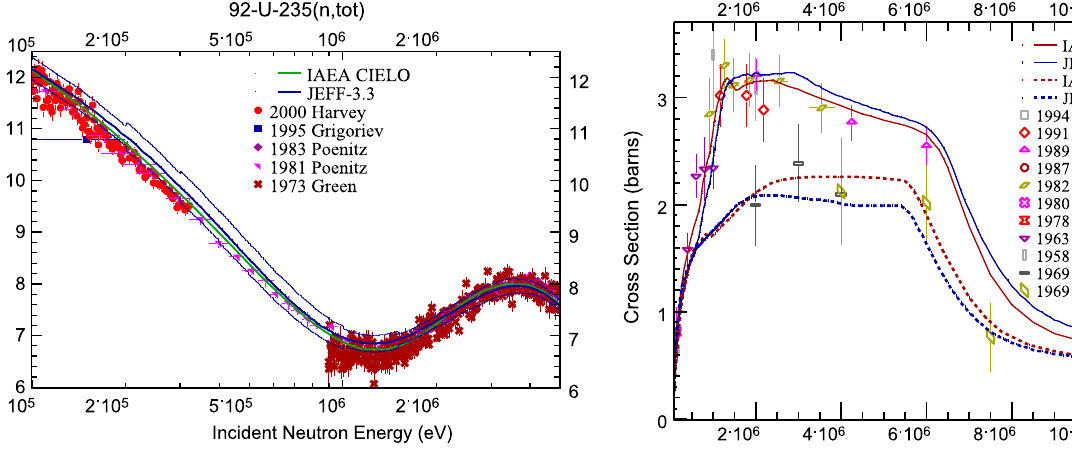
Fig. 1. Evaluated cross sections from IAEA CIELO and JEFF- 3.3 libraries for 235 U ( n ,tot) compared to selected experimental data from EXFOR [20].